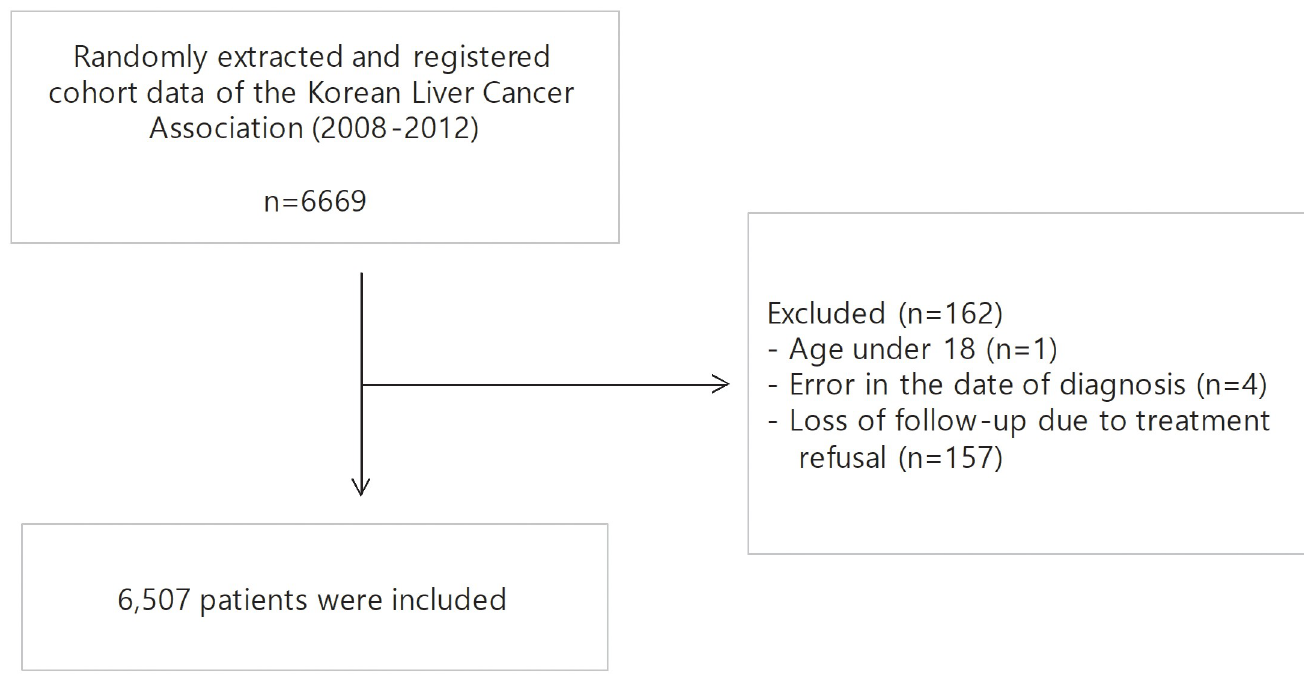
Fig 1. Flow chart of this